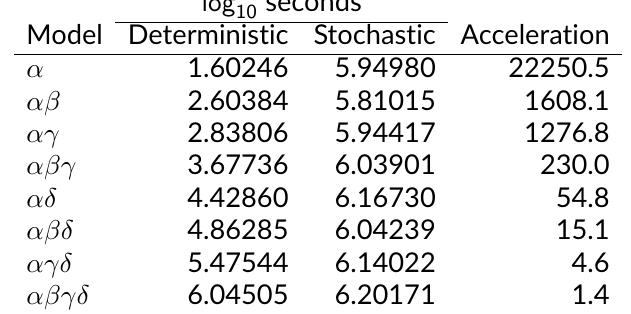
Table 2 – CPU time expended in analysis of each model from Rogers, Harris, and Achen- bach [24]. Each analysis involves 204 runs of legofit and 1 run of pclgo. Elapsed times were much shorter, because calculations were done in parallel. “Acceleration” is the ratio of execution speed in the deterministic model to that in the stochastic model. Models are arranged in order of increasing execution time with the deterministic algorithm.